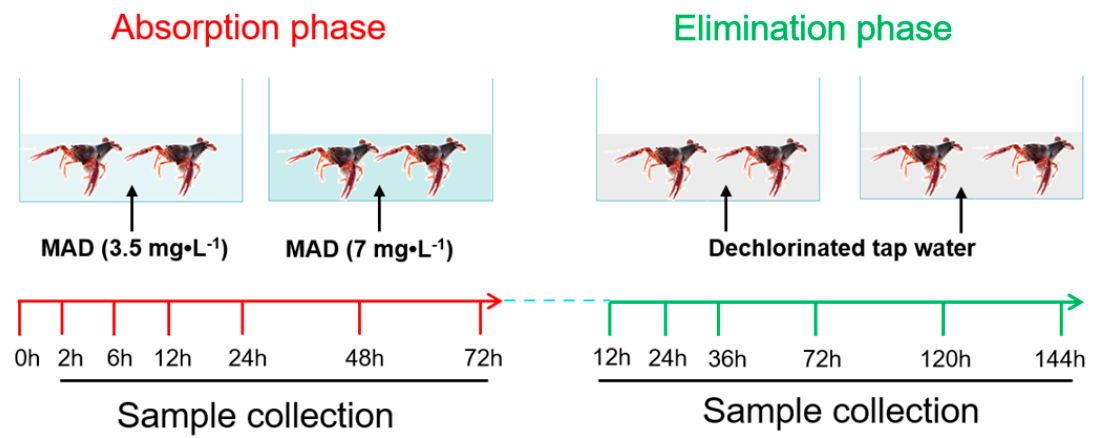
Figure 1. Experimental design for the absorption and elimination phases of maduramicin (MAD) in crayfish.